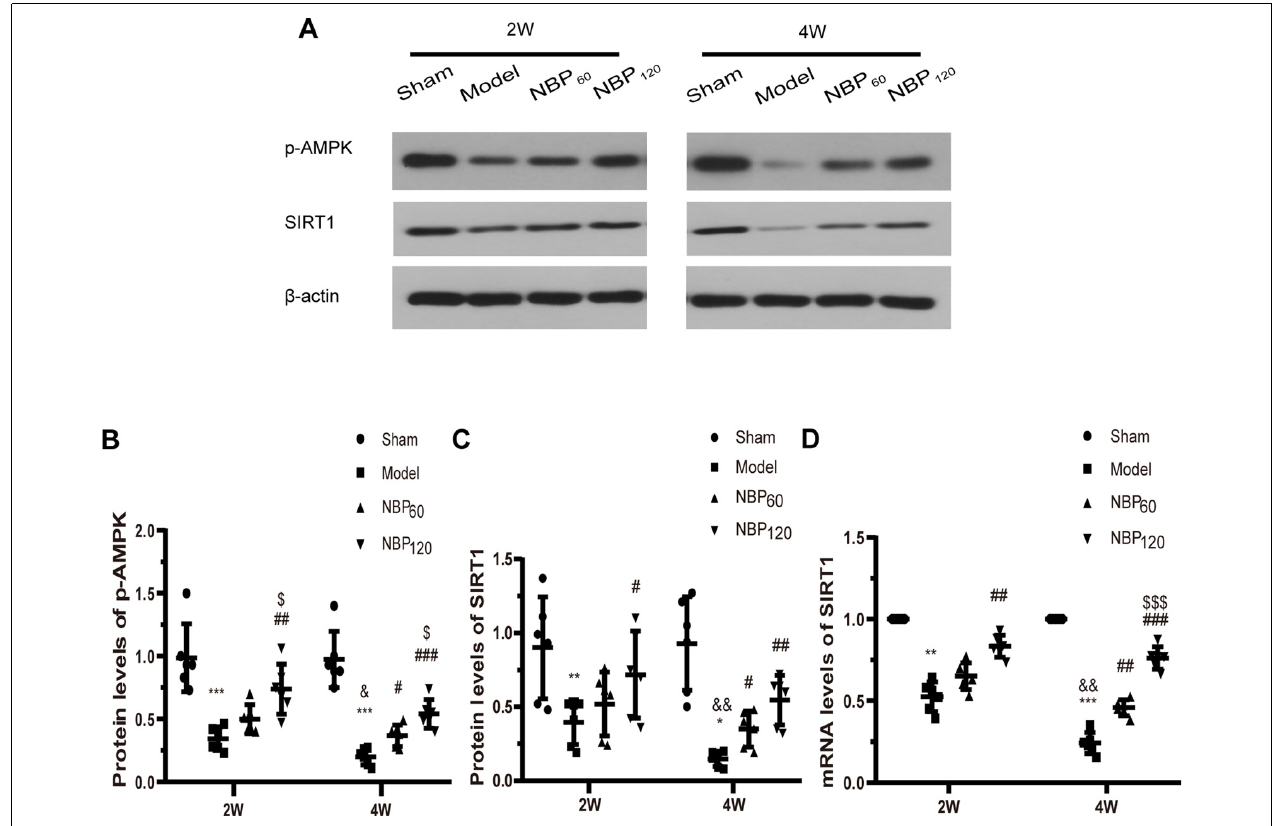
FIGURE 7 | Dl-3-n-butylphthalide (NBP) upregulates AMPK/SIRT1 signaling after 2VO. (A) Western blot analysis of the expressions of p-AMPK and SIRT1 ( n = 6 in each group). (B) Quantitative analysis of protein levels of p-AMPK. (C) Quantitative analysis of protein levels of SIRT1. (D) Quantitative analysis of mRNA levels of SIRT1 ( n = 6 in each group). β -actin was used as an internal control. * p < 0.05, ** p < 0.01, *** p < 0.001, the model group vs. the sham group; # p < 0.05, ## p < 0.01, ### p < 0.001, the NBP60 group or NBP120 group vs. the model group; $ p < 0.05, $$$ p < 0.001, the NBP60 group vs. NBP120 group; and & p < 0.05, && p < 0.01, the model group sacrificed at 2 weeks vs. the model group sacrificed at 4 weeks. Values are expressed as mean ± SD. p-AMPK, phosphorylated AMP-activated protein kinase. SIRT1, silent mating type information regulation 2 homolog